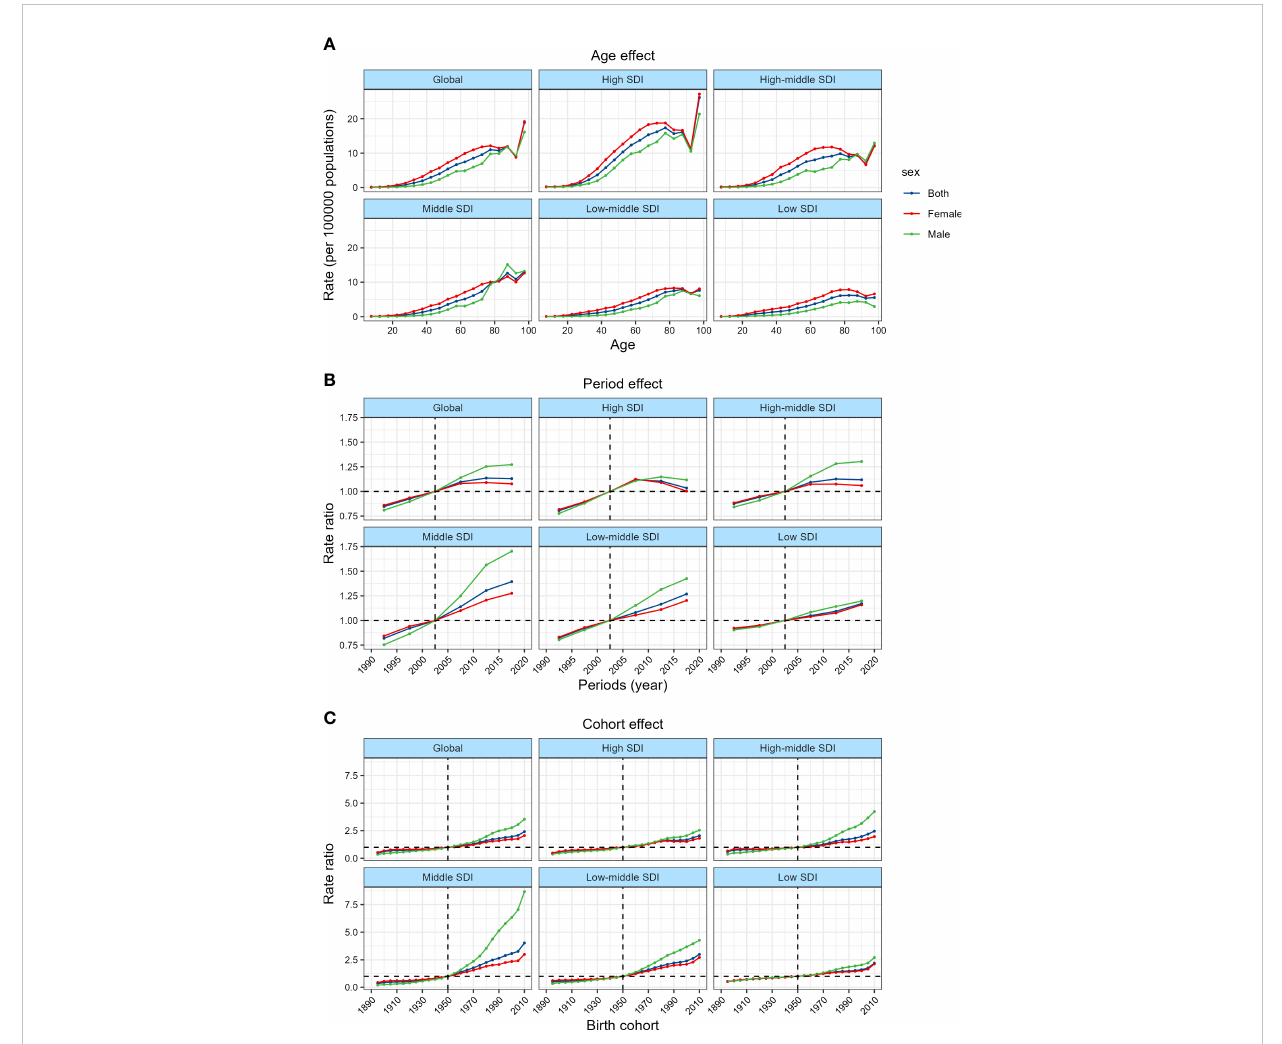
FIGURE 1 Age, period and cohort effects on TC incidence by SDI quintiles. (A) Age effects are shown by the fi tted longitudinal age curves of incidence (per 100,000 person-years) adjusted for period deviations. (B) Period effects are shown by the relative risk of incidence (incidence rate ratio) and computed as the ratio of age-speci fi c rates from 1990~1994 to 2015~2019 (2000~2005 as the referent period). (C) Cohort effects are shown by the relative risk of incidence and computed as the ratio of age-speci fi c rates from the 1895 cohort to the 2010 cohort, with the referent cohort set at